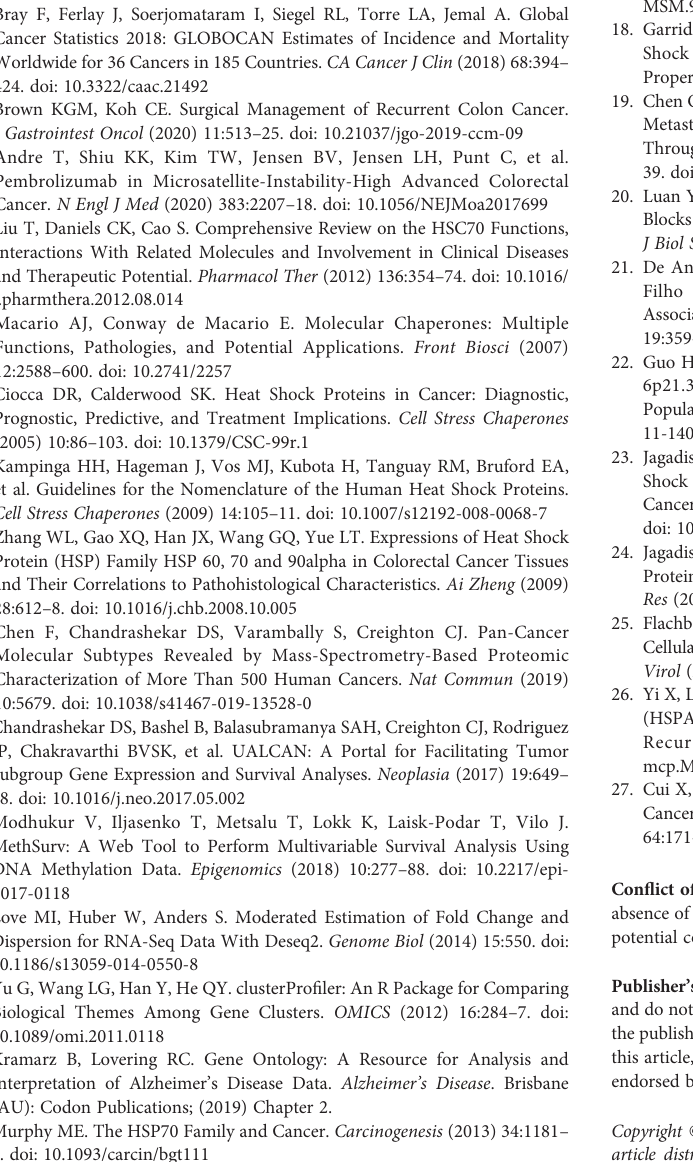
Supplementary Figure 2 | Correlation of HSPA family expression with clinical pathological characteristics in colon cancer. Correlation of HSPA8, HSPA9, HSPA12A, HSPA12B, HSPA13 and HSPA14 expression with (A) T stage, (B) N stage, (C) M stage, (D) pathologic stage, (E) age, (F) gender, (G) CEA level. (Wilcoxon rank sum test for T stage, N stage, M stage, age, gender and CEA level. Kruskal-Wallis test for pathologic stage. ns, non signi fi cant; * P < 0.05; ** P < 0.01; *** P < 0.001).